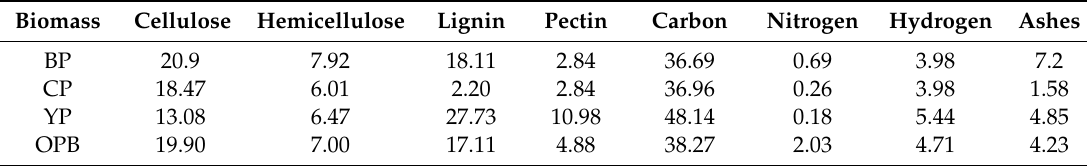
Table 3. Proximate and ultimate analysis for selected